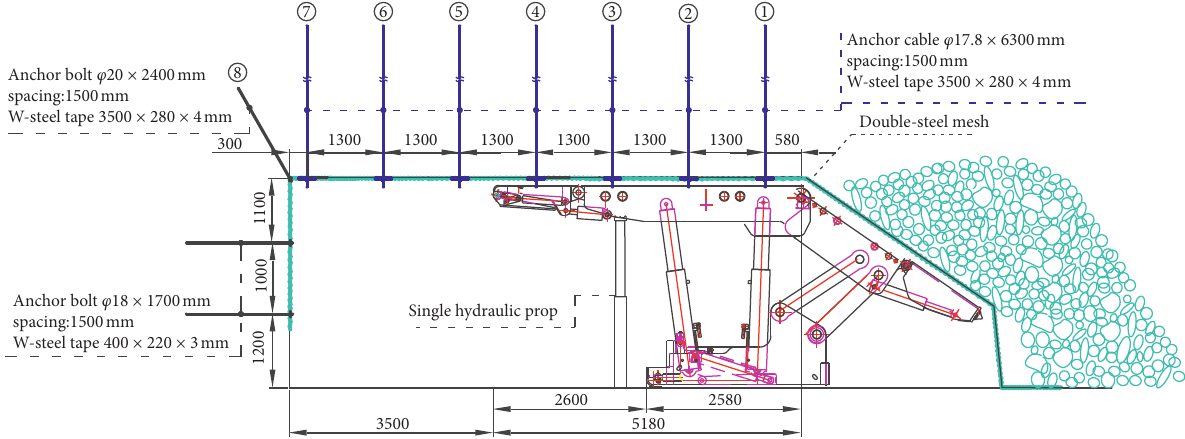
Figure 3: Previous support scheme of N0481 retracement